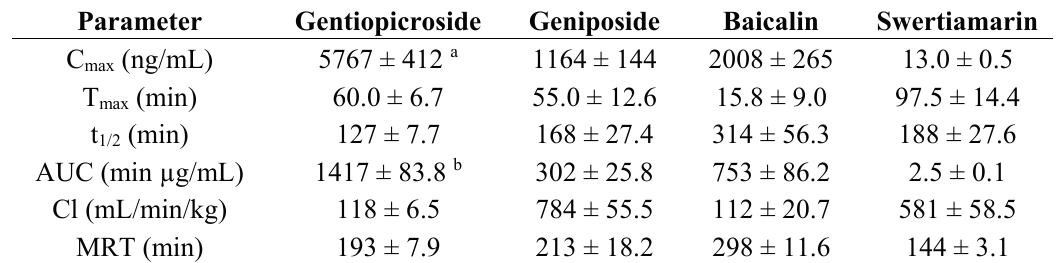
Table 5. Pharmacokinetic parameters of the four components in rat plasma after oral administration of LDXGT (10 g/kg,